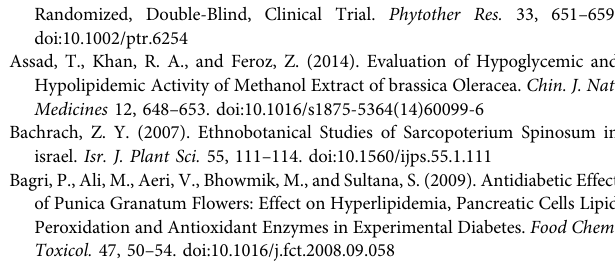
Frontiers in Pharmacology |